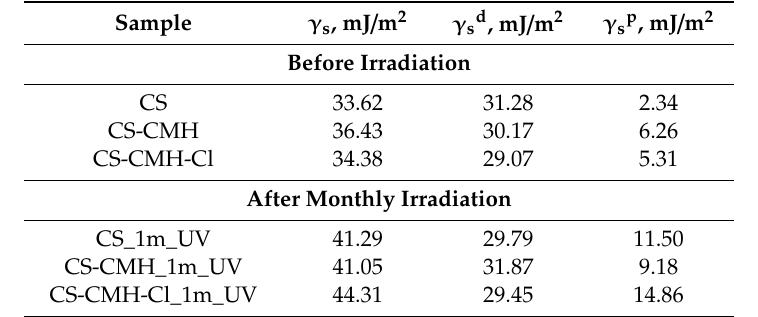
Table 3. Values of the surface free energy ( γ s ) and its polar ( γ sp ) and dispersive ( γ sd ) components for CS-samples before and after monthly